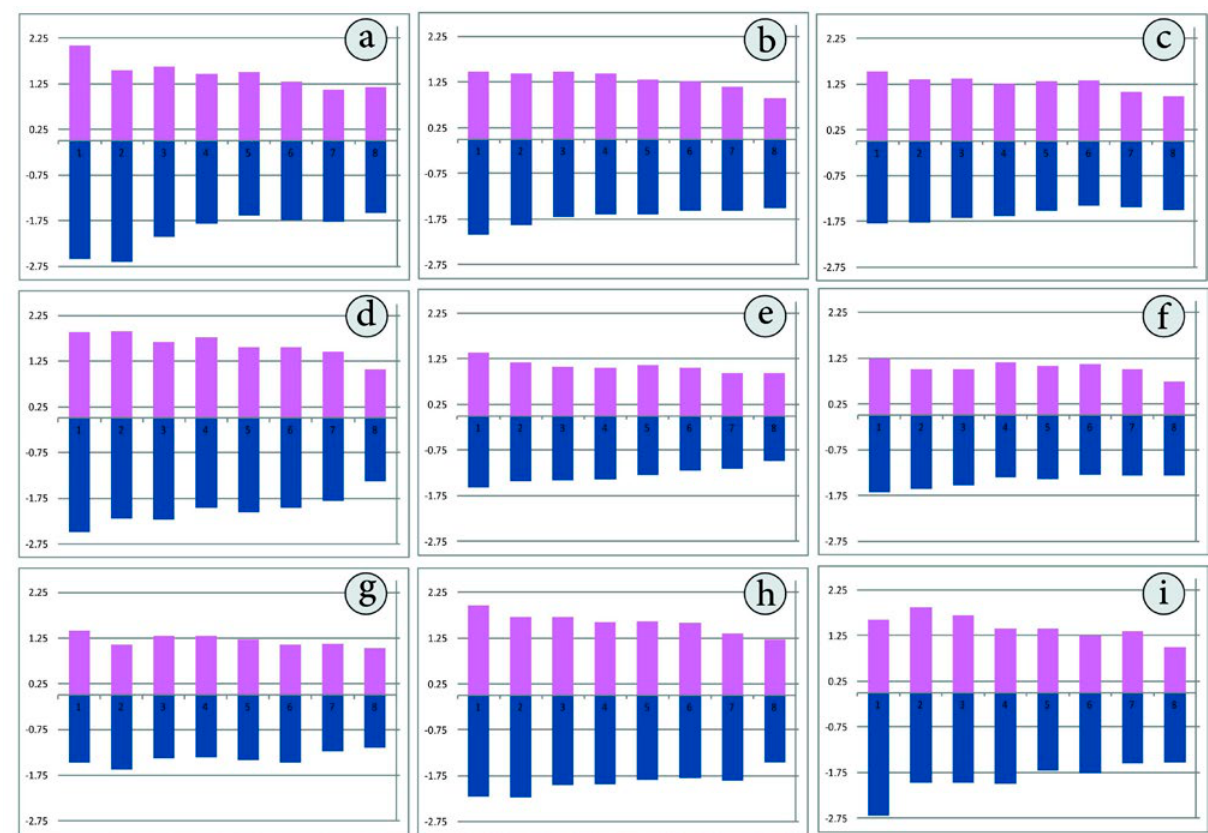
Figure 2. Haploid ideograms of Trigonella taxa. (a, b) T. binaloudensis from two locality; (c) T. heratensis ; (d) T. lasiocarpa ; (e) T. stipitata; (f, g, h) T. subenervis from three locality; (i) T. torbatejamensis . in all of studied taxa